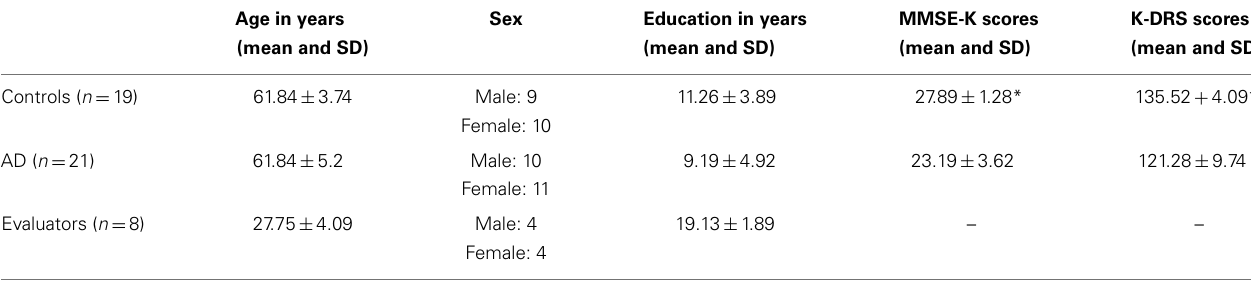
Table 1 | Subjects’ and evaluators’ demographic data .